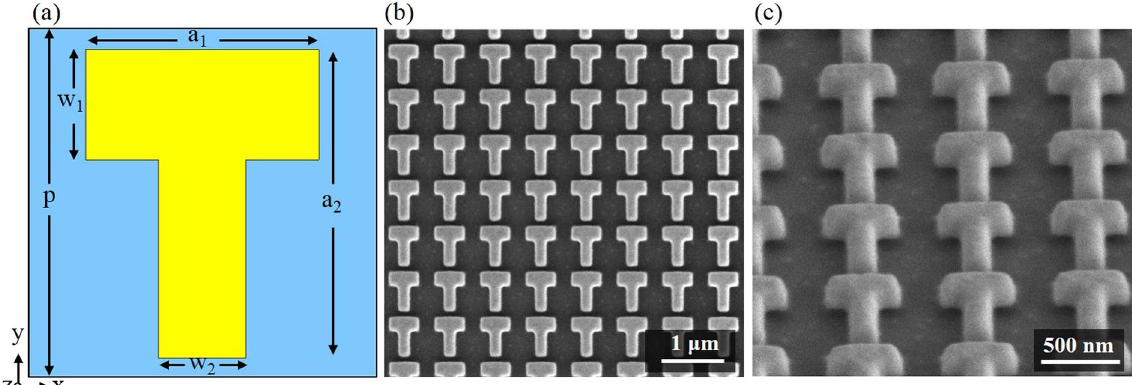
Figure 1. ( a ) Schematic of the designed T-shaped antenna unit cell and the geometric dimensions: a 1 = 475 nm, a 2 = 630 nm, w 1 = 225 nm, w 2 = 180, p = 720 nm, and the gold film thickness is 180 nm. ( b ) and ( c ) Top-view and perspective-view SEM images of the fabricated T-shaped antenna array on glass